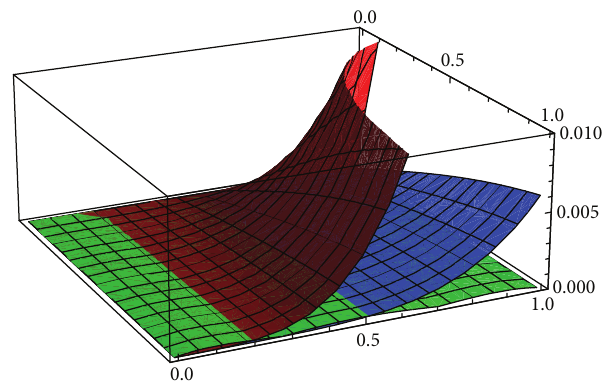
Figure 2: The absolute differences corresponding to the HPM solution (red surface), VIM solution (blue surface), and OHPM solution (green surface) for problem (19).